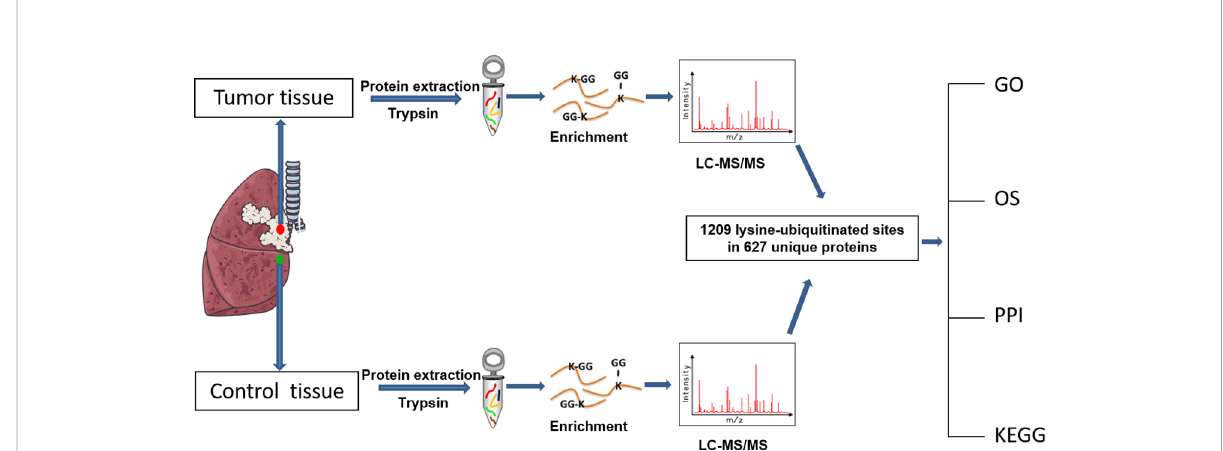
FIGURE 1 Experimental fl ow-chart and bioinformatics analysis that were used in this